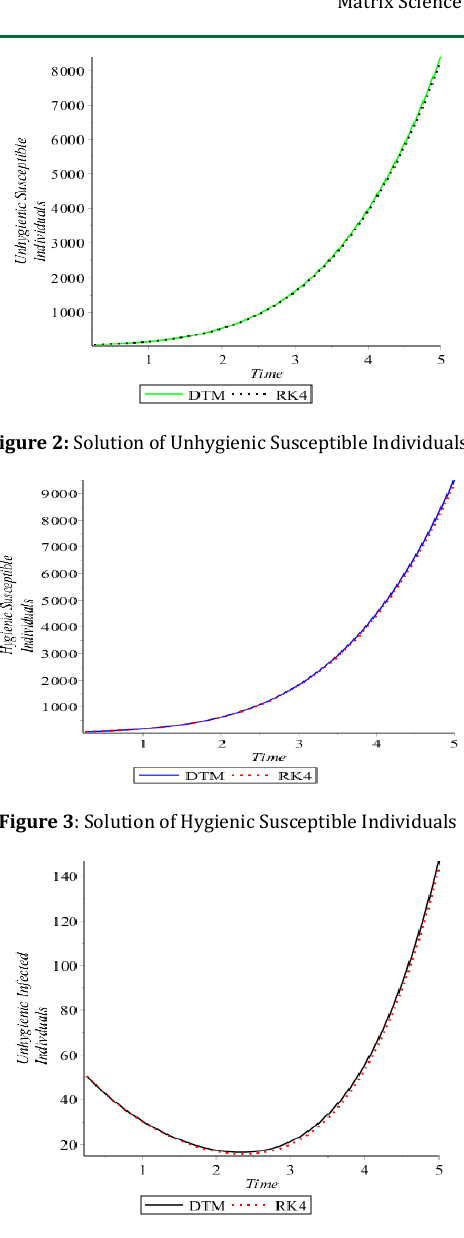
Figure 4: Solution of Unhygienic Infected Individuals